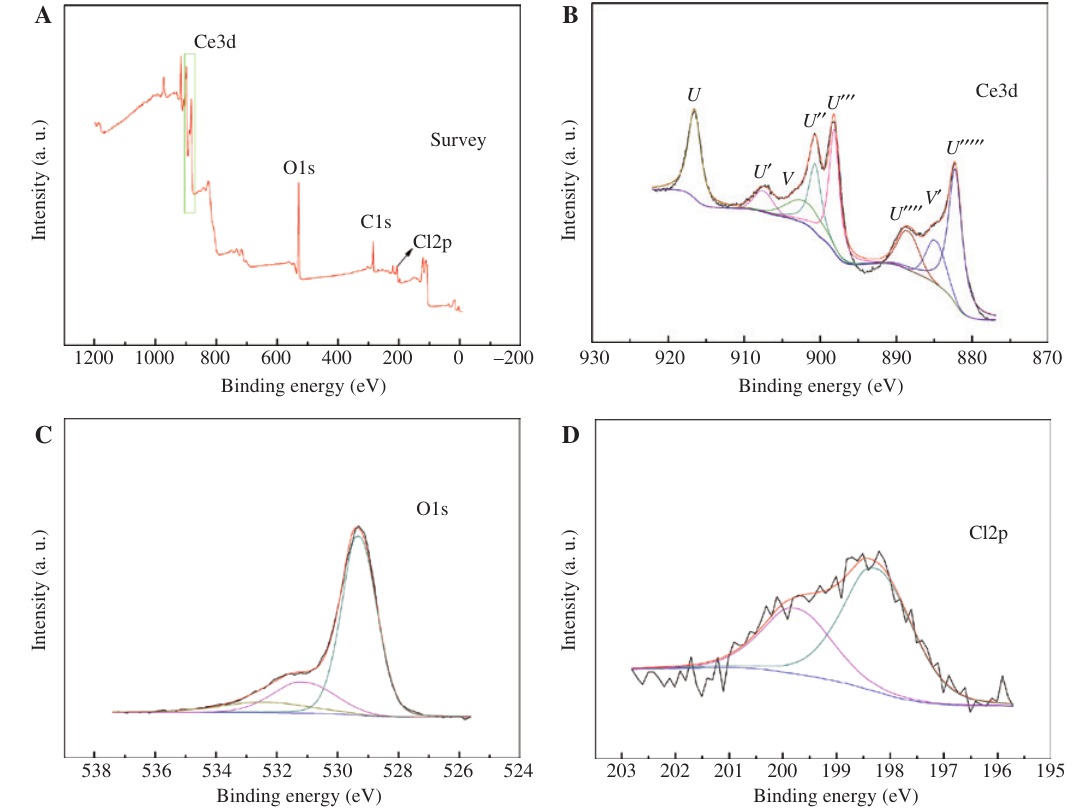
microsphere prepared at 700 ° C. 2